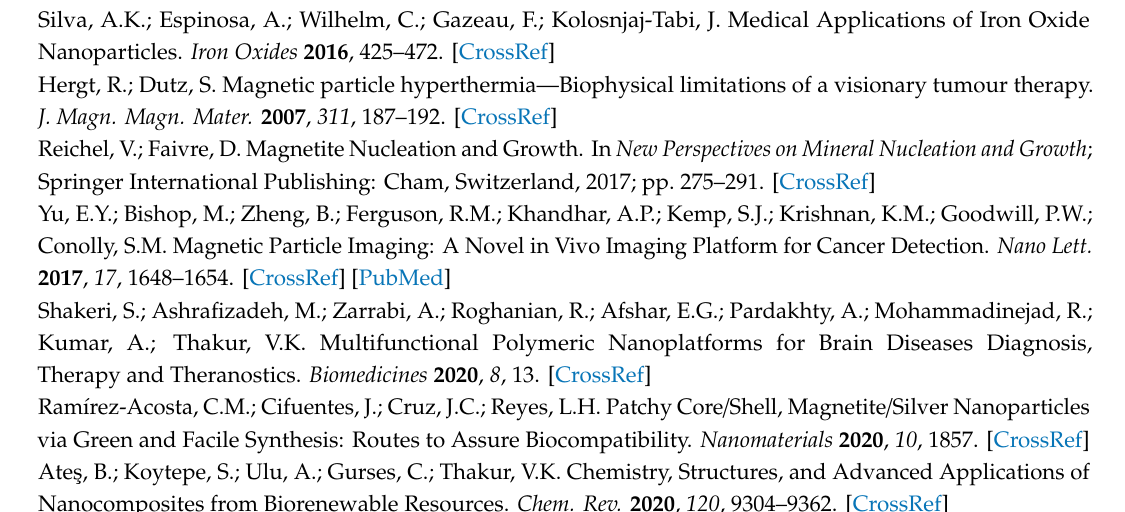
Figure S1: Biological e ff ects of Resovist ® particles on endothelial cells grown in static conditions by real-time cell analysis, Figure S2: Live-cell microscopy of HUVECs treated with Resovist ® particles, Figure S3: Semi-quantitative analysis of confluence in non-uniform and laminar regions of the bifurcating